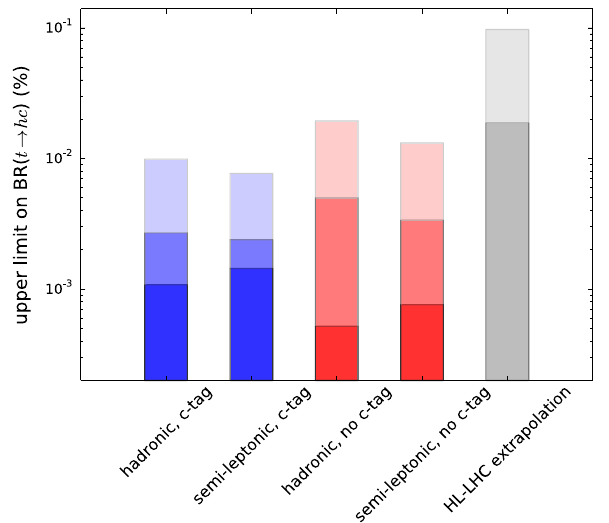
Fig. 4 The upper limits on the branching ratio BR( t → hc ) as a per- centage of the total, as calculated by each of the phenomenological analyses of this article for a 100 TeV FCC-hh with an integrated lumi- nosity of 10 ab − 1 . The (blue and red) bars represent the 95% C.L. limits taking into account systematic uncertainties α = ( 0 , 0 . 05 , 0 . 2 ) going from darker to lighter-shaded, respectively. The blue bars represent the cases with charm-jet tagging applied, whereas the red bars represent the cases without it. The darker grey bar represents a naive statistical extrapolation of the ATLAS constraints that appear in [29] to the full high-luminosity LHC data set (3000 fb − 1 ) in the absence of system- atic uncertainties ( α = 0) and the lighter-shaded grey area roughly takes into account the current estimate of the systematic uncertainties, corresponding to α (cid:3) 0 . 063 Table 6 The 95% C.L. upper limits as calculated by each of the phe- nomenological analyses of this article for a 100 TeV FCC-hh with an integratedluminosityof10ab − 1 correspondingtothesystematicuncer- tainty parameter values α = ( 0 , 0 . 05 , 0 . 2 ) as described in the main text. We give the limits on the branching ratios for the top quark as a per- centage of the total as well as the associated values of the coupling, λ h ct . The results for BR( t → hc ) are also given graphically in Fig 4 Analysis Hadr.